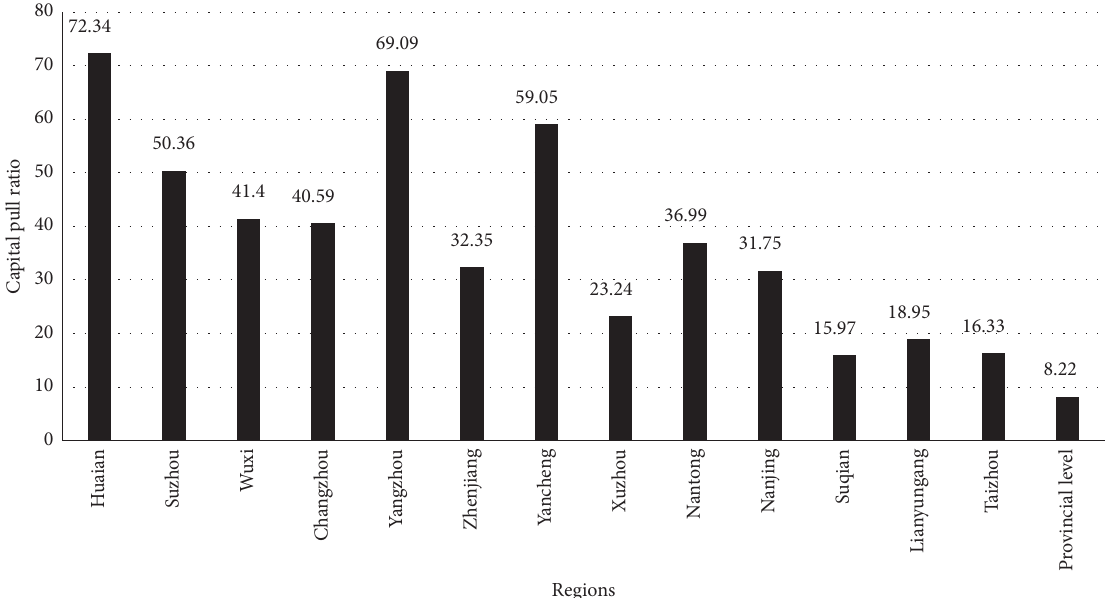
Figure 4: Capital pull ratio of Jiangsu Province from 2011 to 2018.